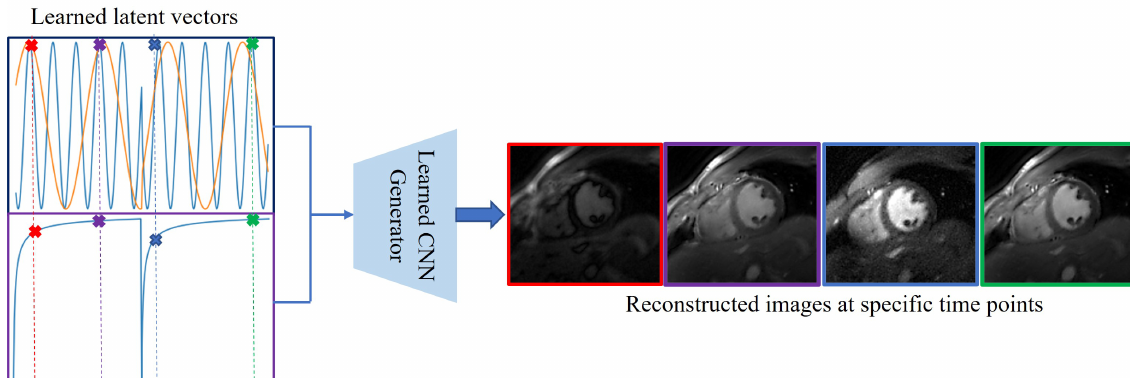
Figure 5. Illustration of learned CNN generator and latent vectors. The 2D latent vectors are learned from the dense-auto-encoder, and we also have the 1D conditioning vector involving the inversion time. The 3D latent vectors are then fed into the trained CNN generator, and the generator then generates the desired image frames in the time-series. We showed four generated images in this figure. The latent vectors corresponding to these four images are also marked in the